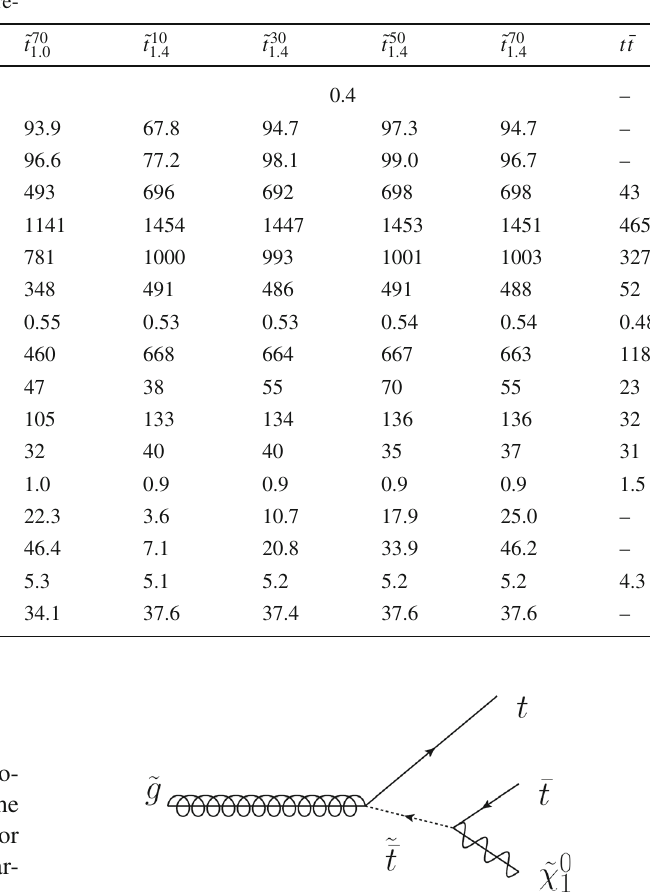
sponds to the number of events with at least one top quark decaying in the tracker volume